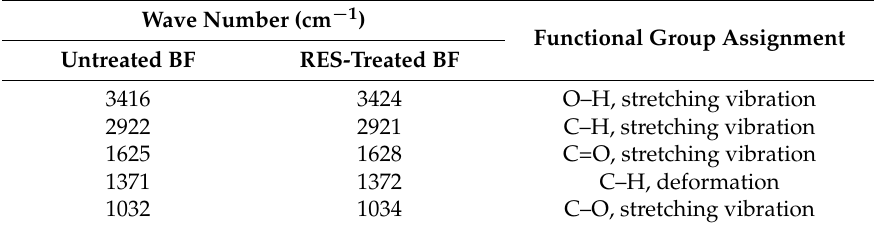
Figure 7. FT-IR spectra of BF. Table 5. Assignment of the wave number in the IR spectra of BF before and after the modification. Wave Number (cm − 1